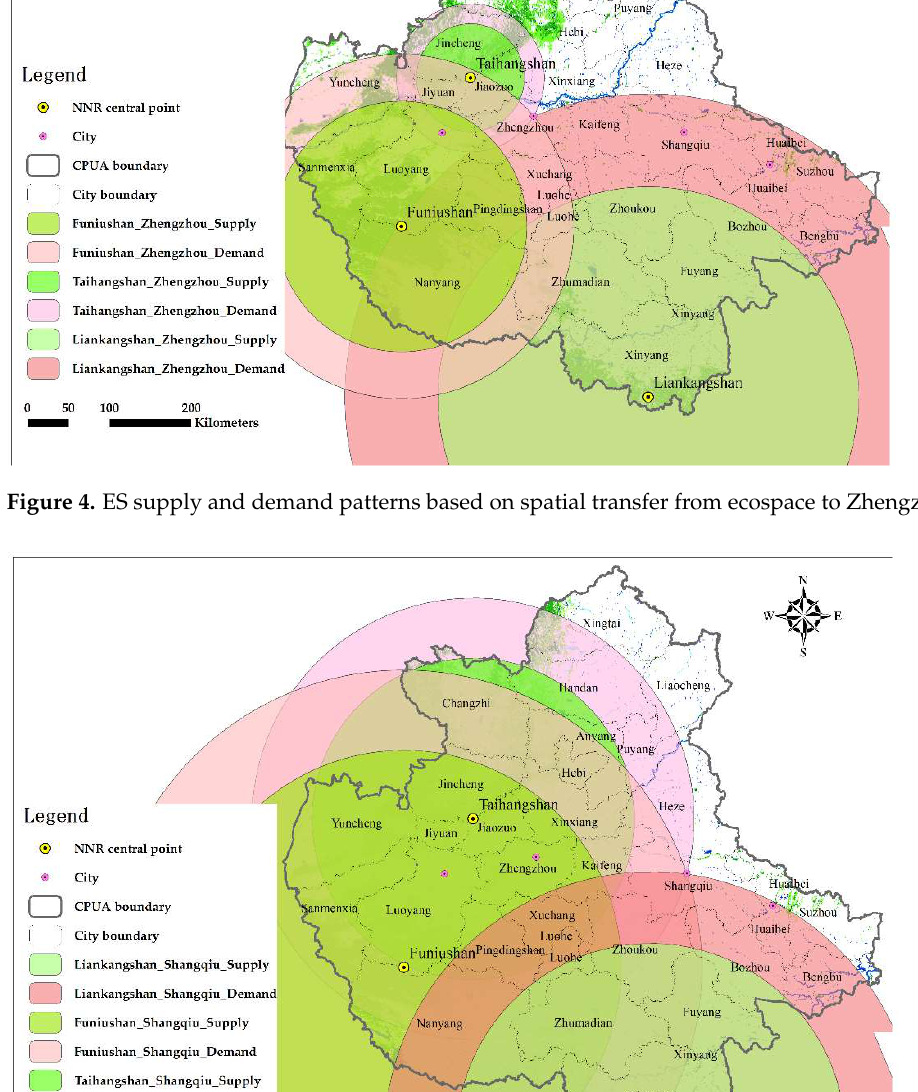
Figure 5. ES supply and demand patterns based on spatial transfer from ecospace to Shangqiu.